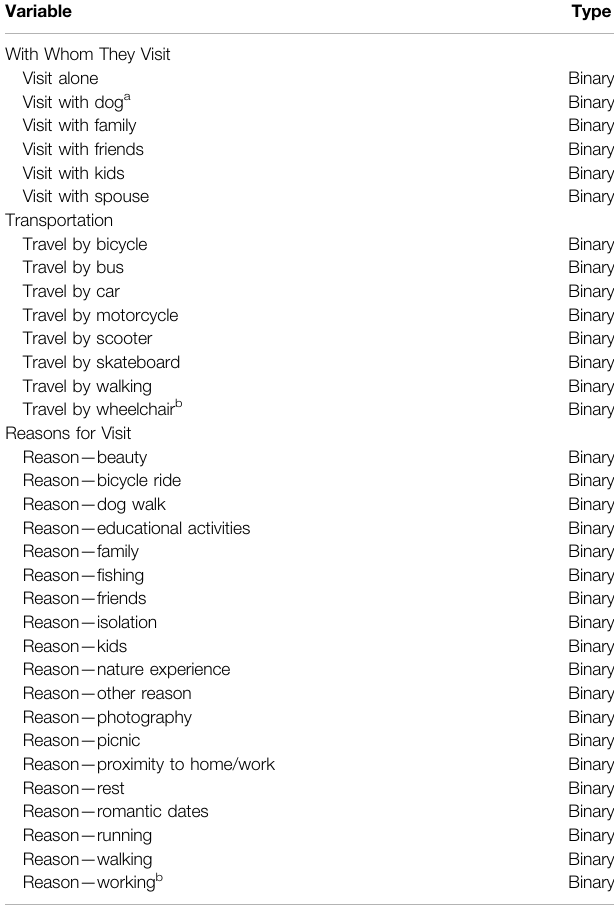
TABLE 1 | Urban nature site variables, including area (hectares), environmental features, and amenities. Variable